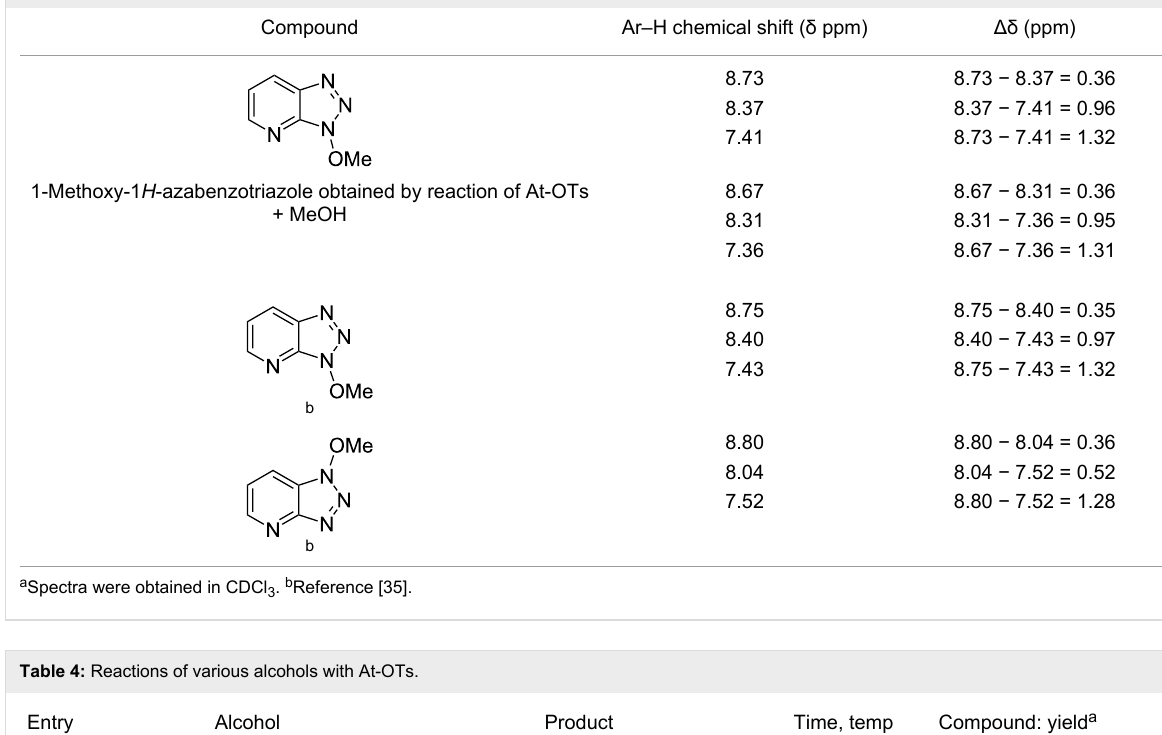
Table 3: Comparison of chemical shifts for the aromatic protons in the isomeric 1-methoxyazabenzotriazoles. a